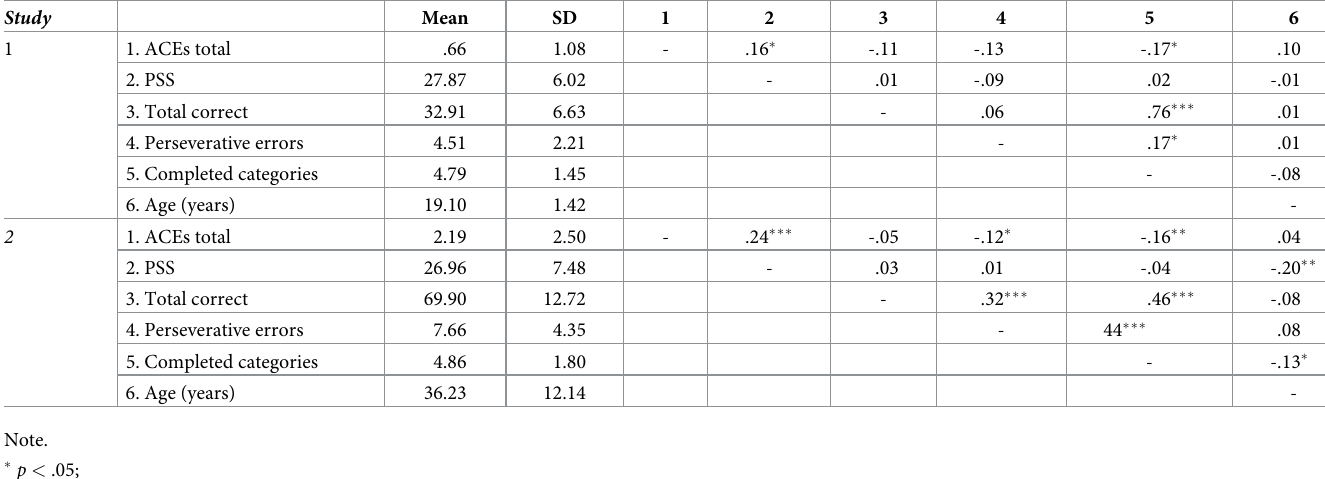
Table 2. Descriptive statistics and bivariate correlations between relevant